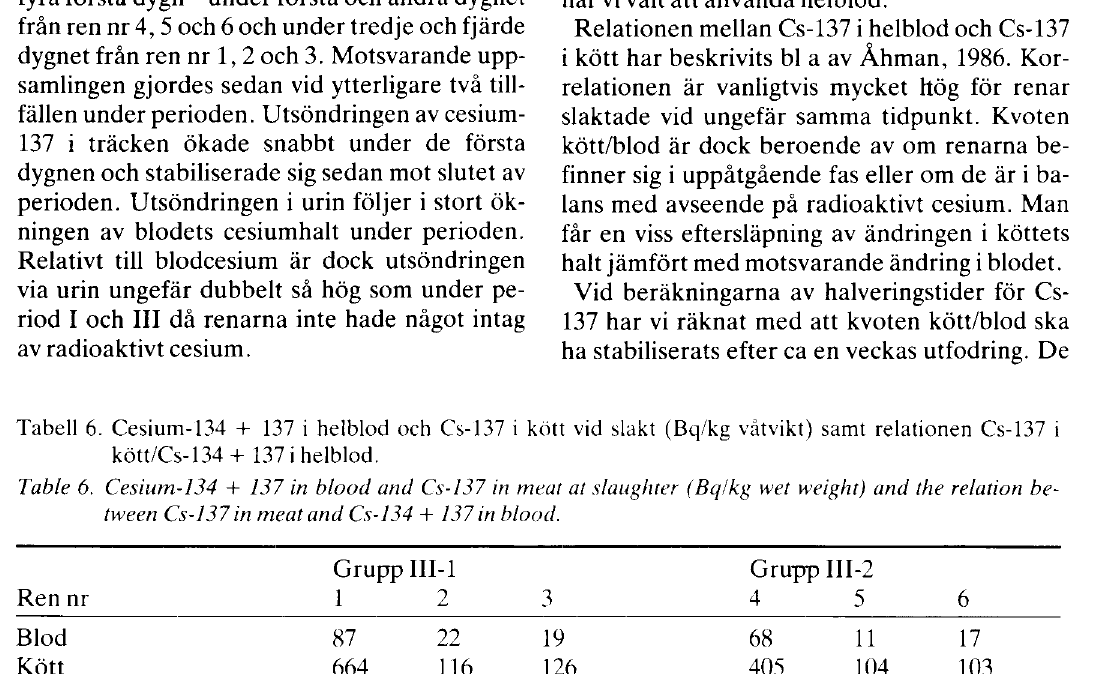
Tabell 7. Utsondringen, under period I, av Cs-137 i urin och track relativt till blodcesium (utsondrat Bq/dag (Medelvårde ± S.D.) Table 7. Excretion, during period I, of Cs-137 in urine and faeces relative to cesium in blood (excreted Bqlday per Bq/kg in blood) when feeding pellets and no supplements (group 1-1), 15 g Klday (group 1-2) or 15 g Kand80g bentonitelday (group 1-3). Mean